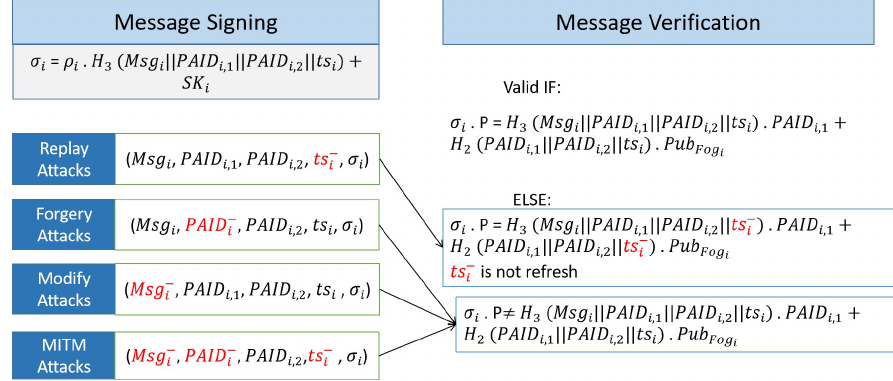
Figure 4. Security attacks resistance.